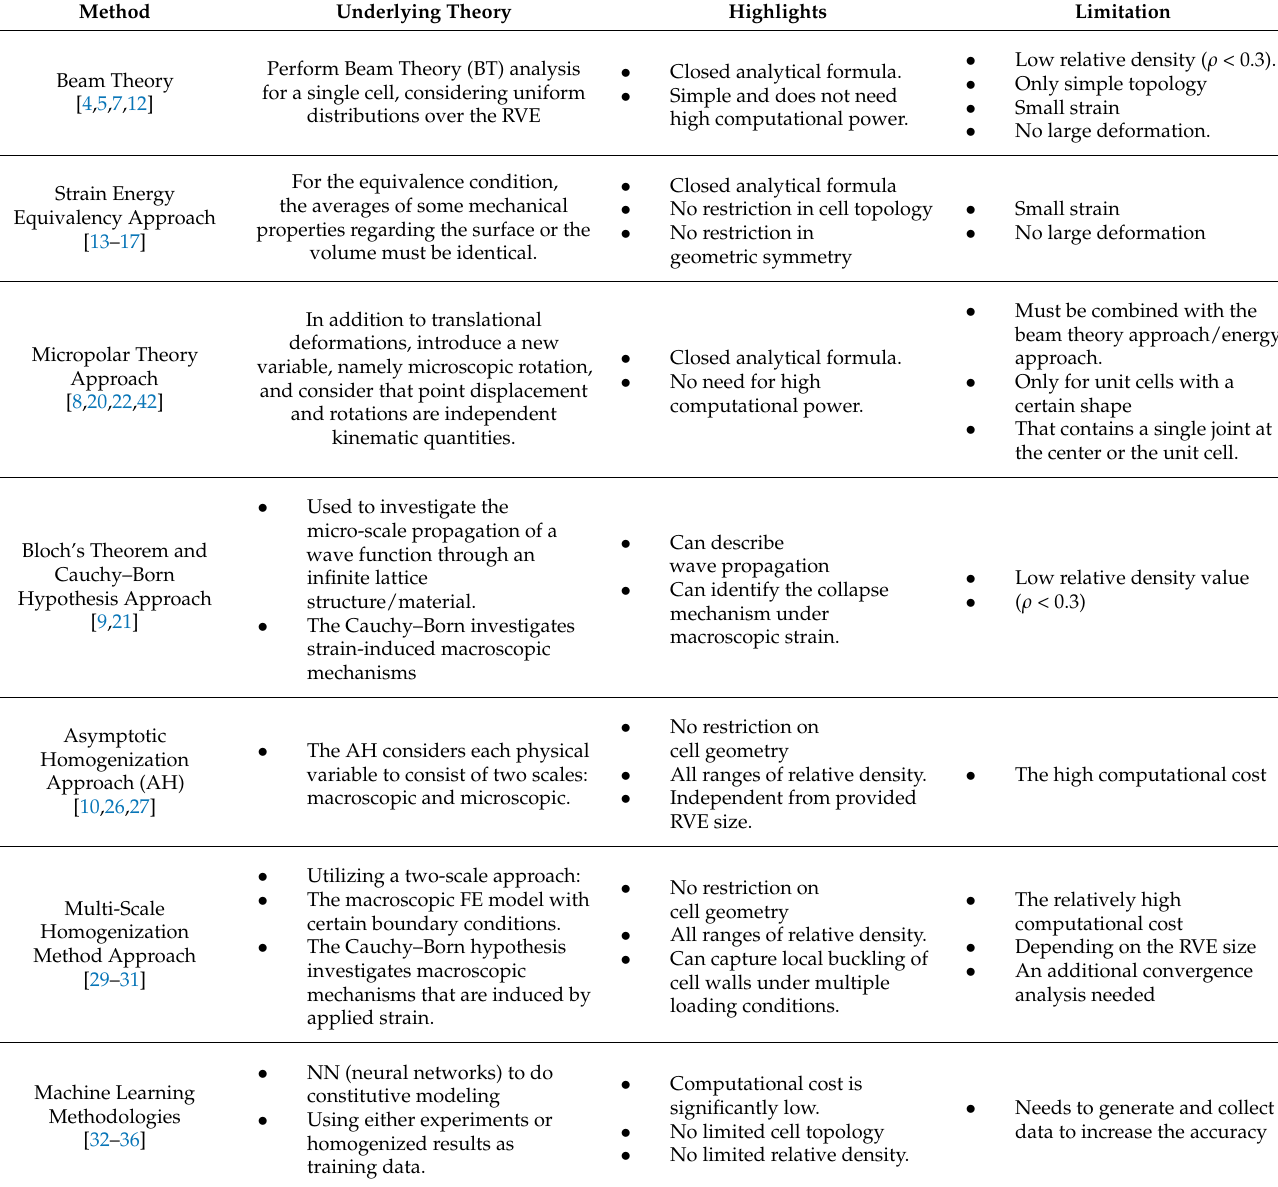
Table 1. Summary of (HM) Homogenization